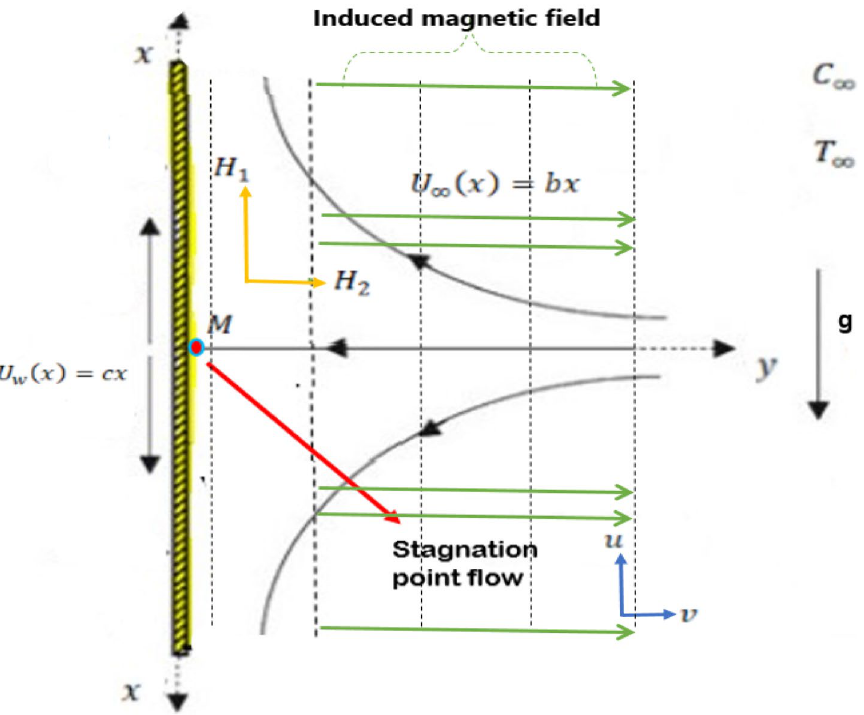
Figure 1. Schematic flow